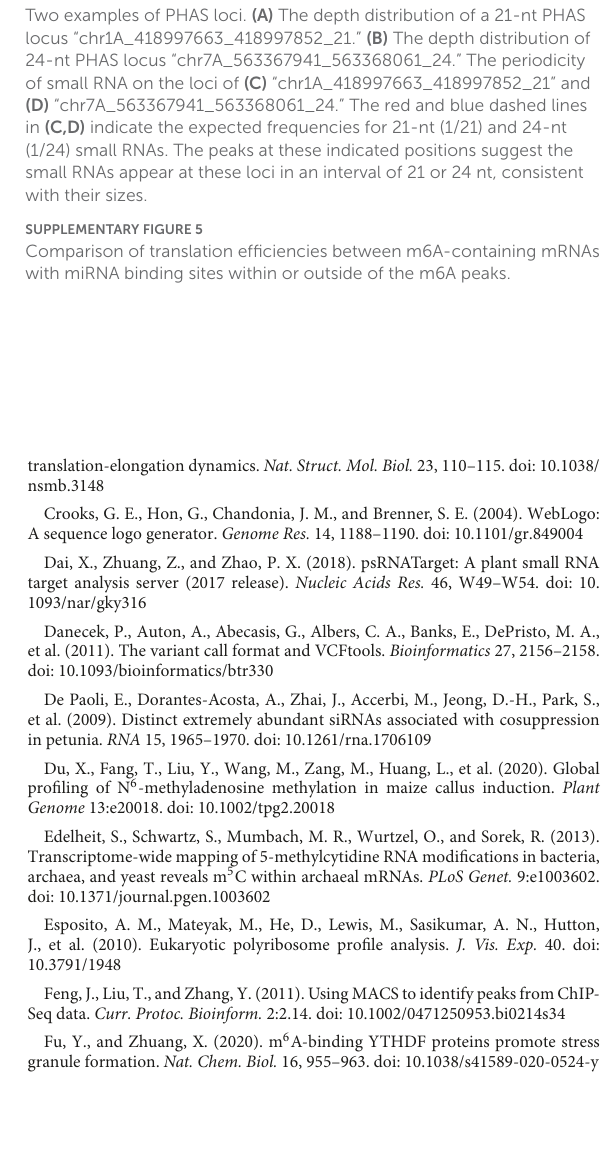
SUPPLEMENTARYFIGURE2 Comparison of translation efficiencies between mRNA and lncRNAs. SUPPLEMENTARYFIGURE3 Size distribution of small